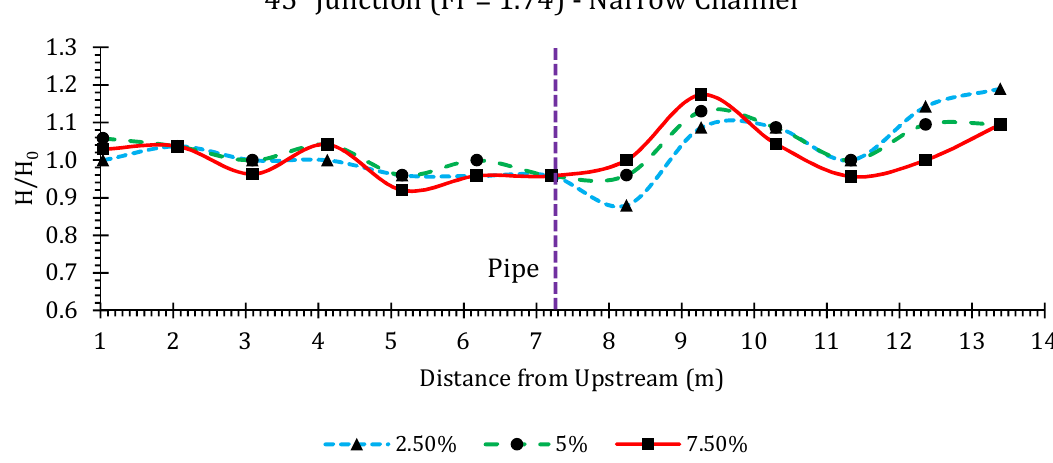
Figure A32. Water height ratios in a 45 ◦ junction for Fr = 1.74 in the narrow Figure A32. Water height ratios in a 45° junction for Fr = 1.74 in the narrow channel. Figure A32. Water height ratios in a 45° junction for Fr = 1.74 in the narrow channel. Figure A32. Water height ratios in a 45° junction for Fr = 1.74 in the narrow channel.